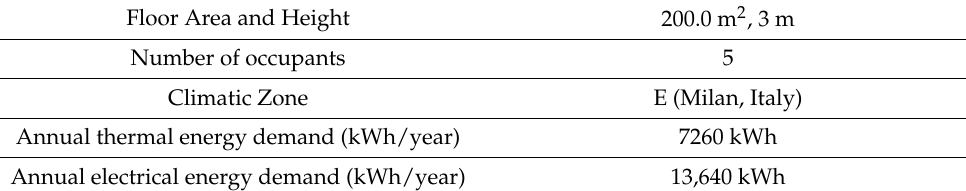
Table 1. Case study